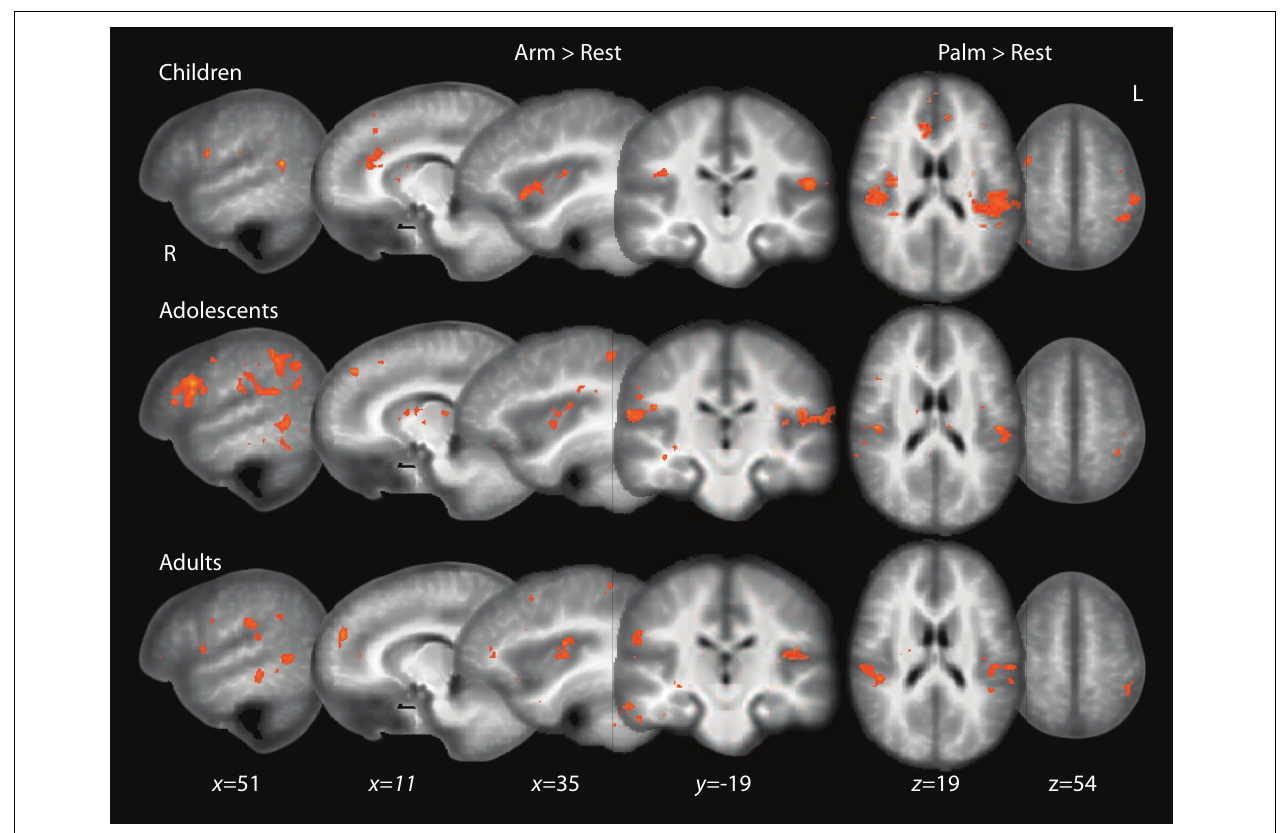
FIGURE 2 | Whole-brain activations to touch in children, adolescents and adults. Adolescent and child maps are thresholded at p < 0 . 01, uncorrected for multiple comparisons. Adult maps are shown at a thresholded of p < 0 . 001, uncorrected.